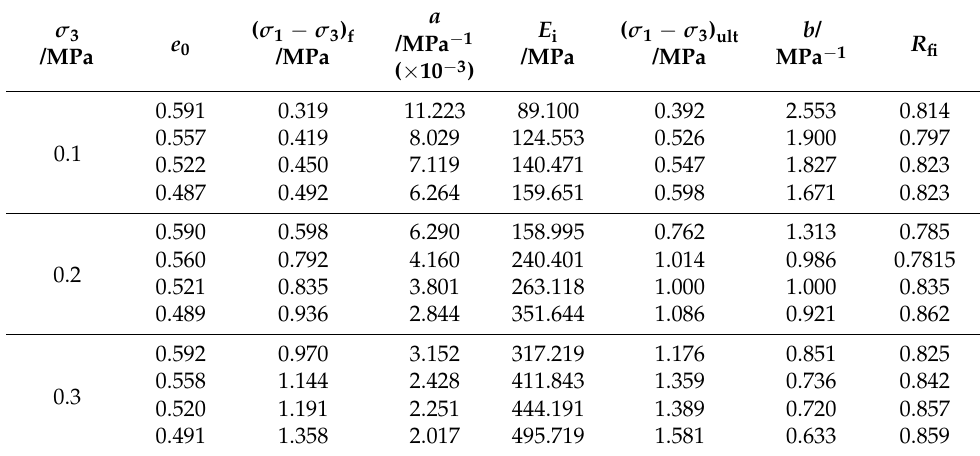
Table 3. Parameters of the ISO dry sands for each